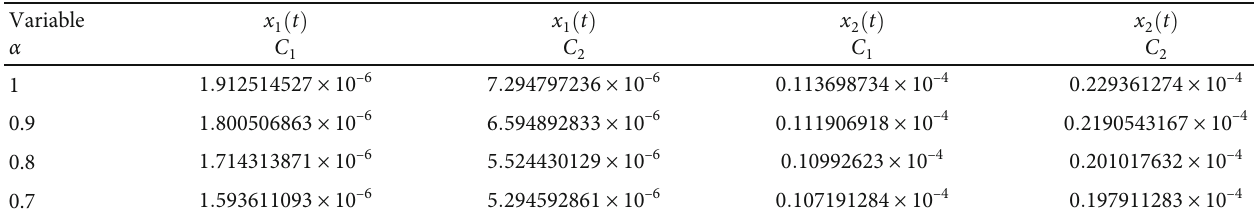
at di ff erent values of α : k